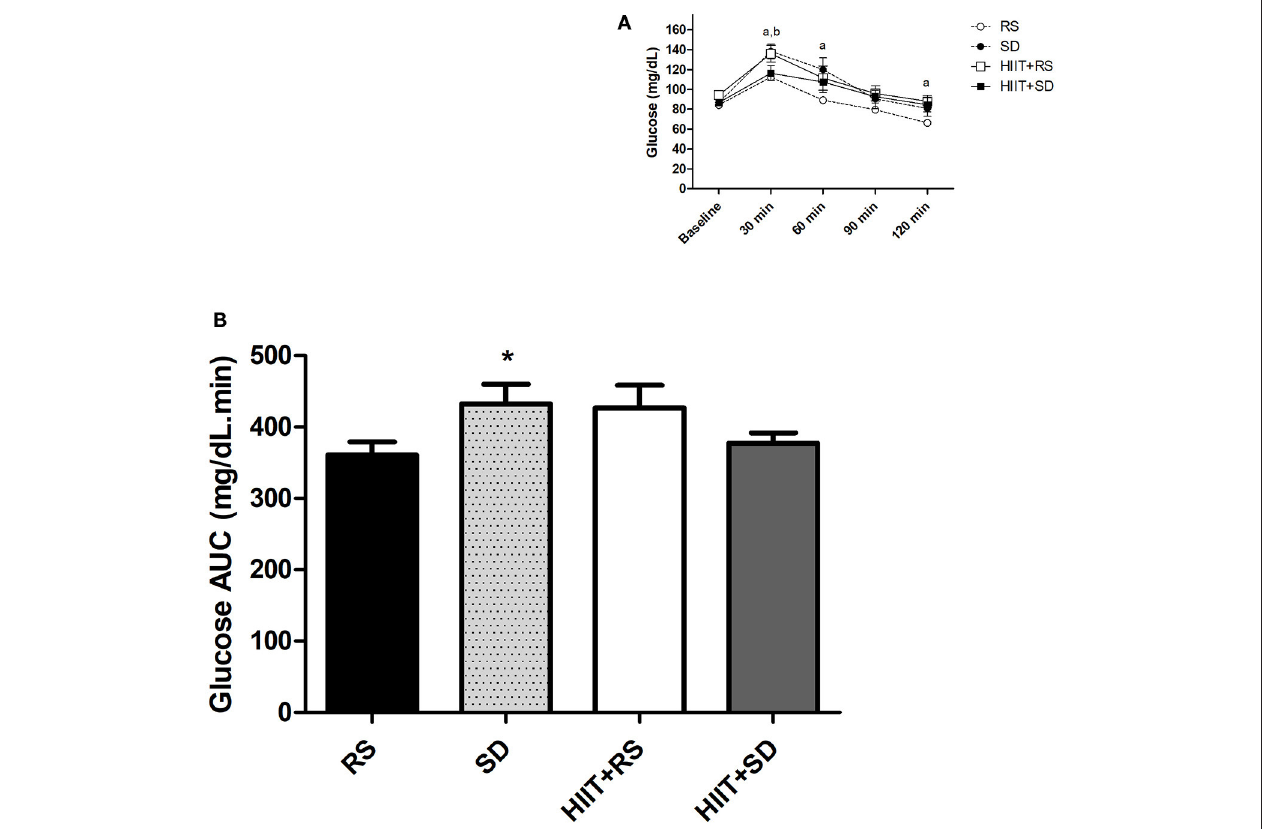
FIGURE 2 | Glycemic curve and area under the curve of glucose. (A) Glycemic curve during OGTT and (B) AUC of Glucose after OGTT. GLM for repeated measures with Post-Hoc Newman Keuls Test. Data presented as mean ± SEM. *Different to RS condition; a RS condition different to SD condition; b HIIT + SD condition different to SD condition. Min, minutes; AUC, Area under the Curve; OGTT, Oral Glucose Tolerance Test.